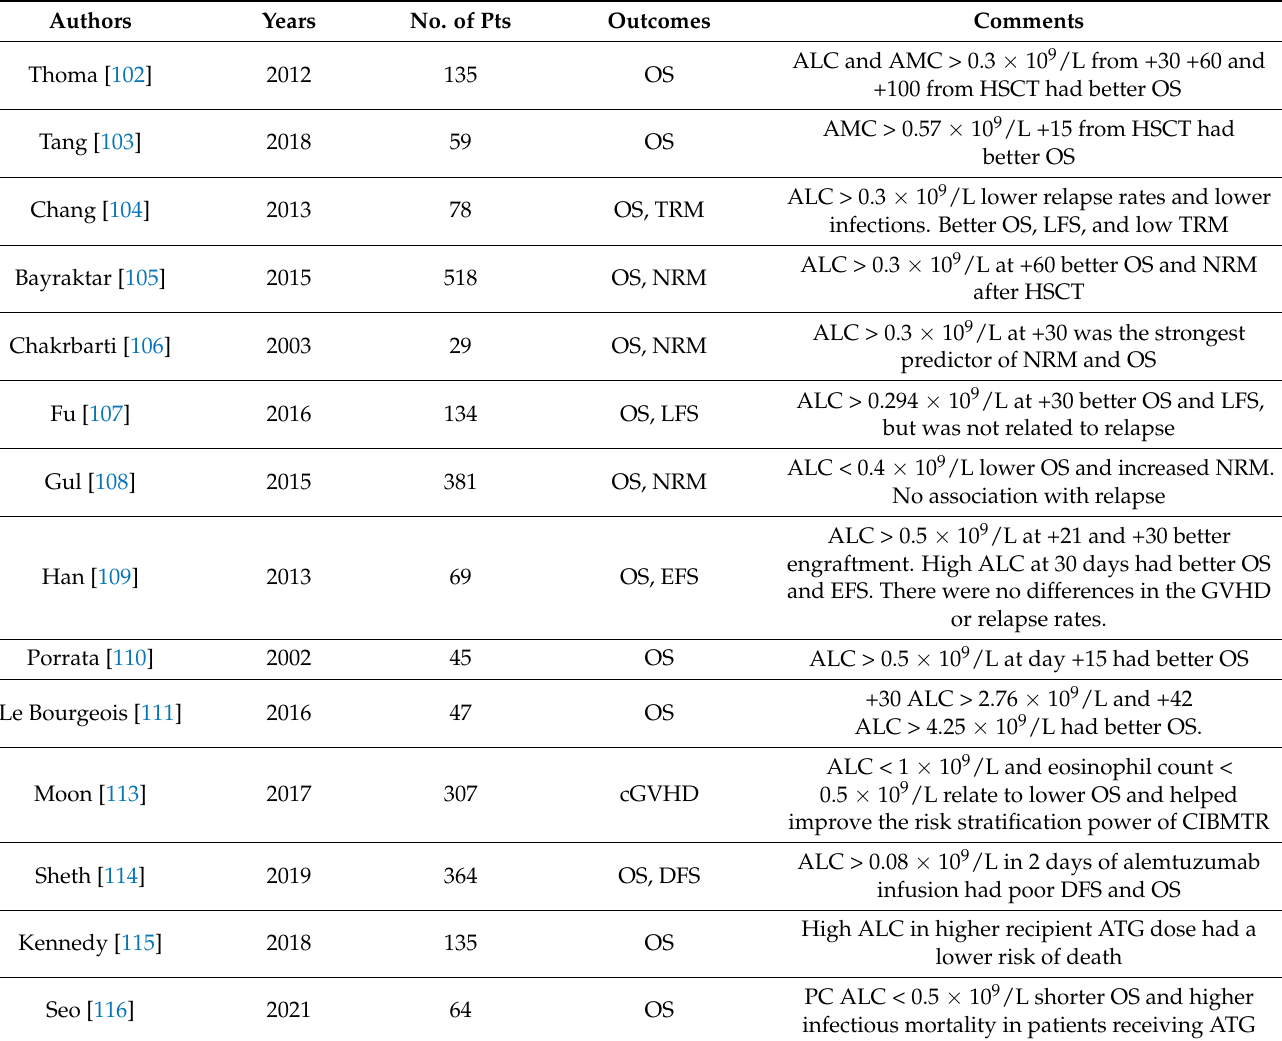
Table 3. Prognostic role of different peripheral count blood cell parameters in bone marrow trans-